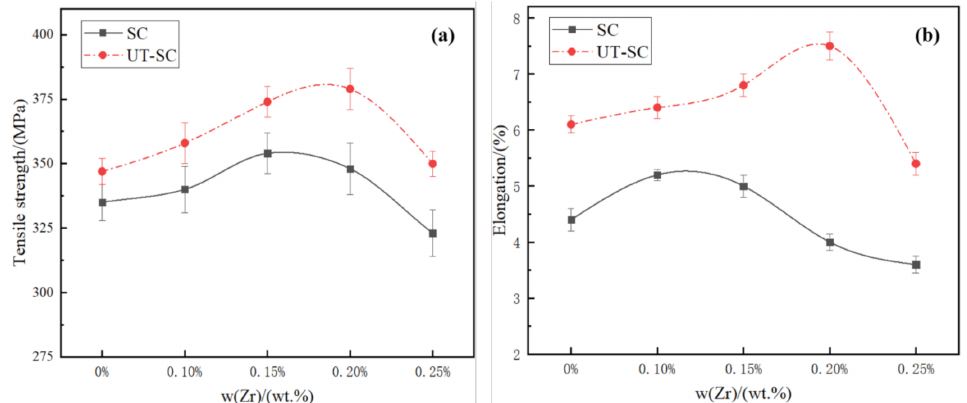
Figure 13. Tensile strength ( a ) and elongation( b ) in as-cast state of SC and UT-SC samples with different